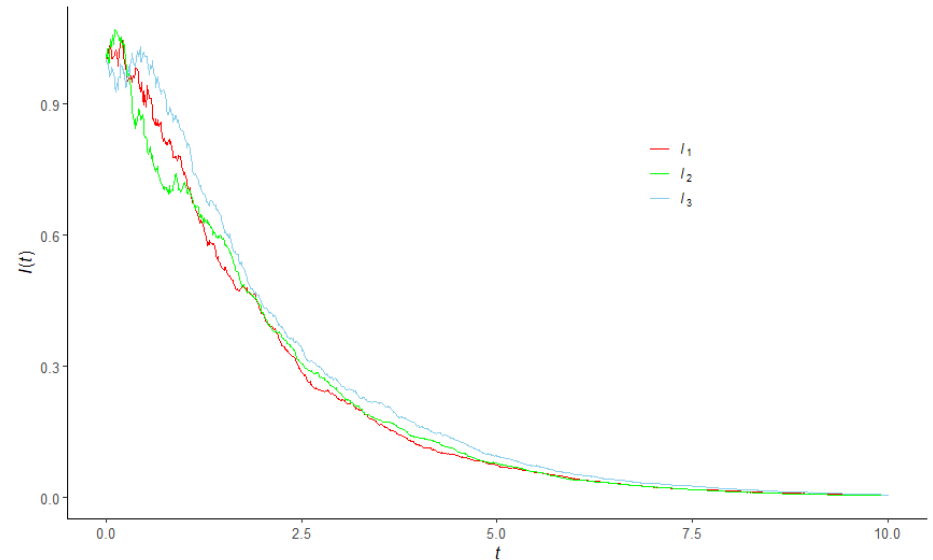
Figure 3. The simulated numbers of infected individuals under condition (a) of Theorem 2.